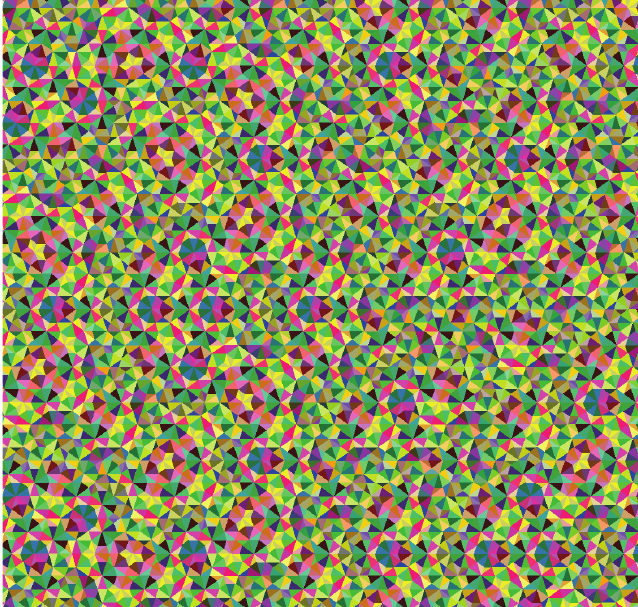
Figure 15: Fragment of a pattern obtained by assigning colors to the collared tiles, after iteration of the inflation rules in Table 1 for Ω Ξ −